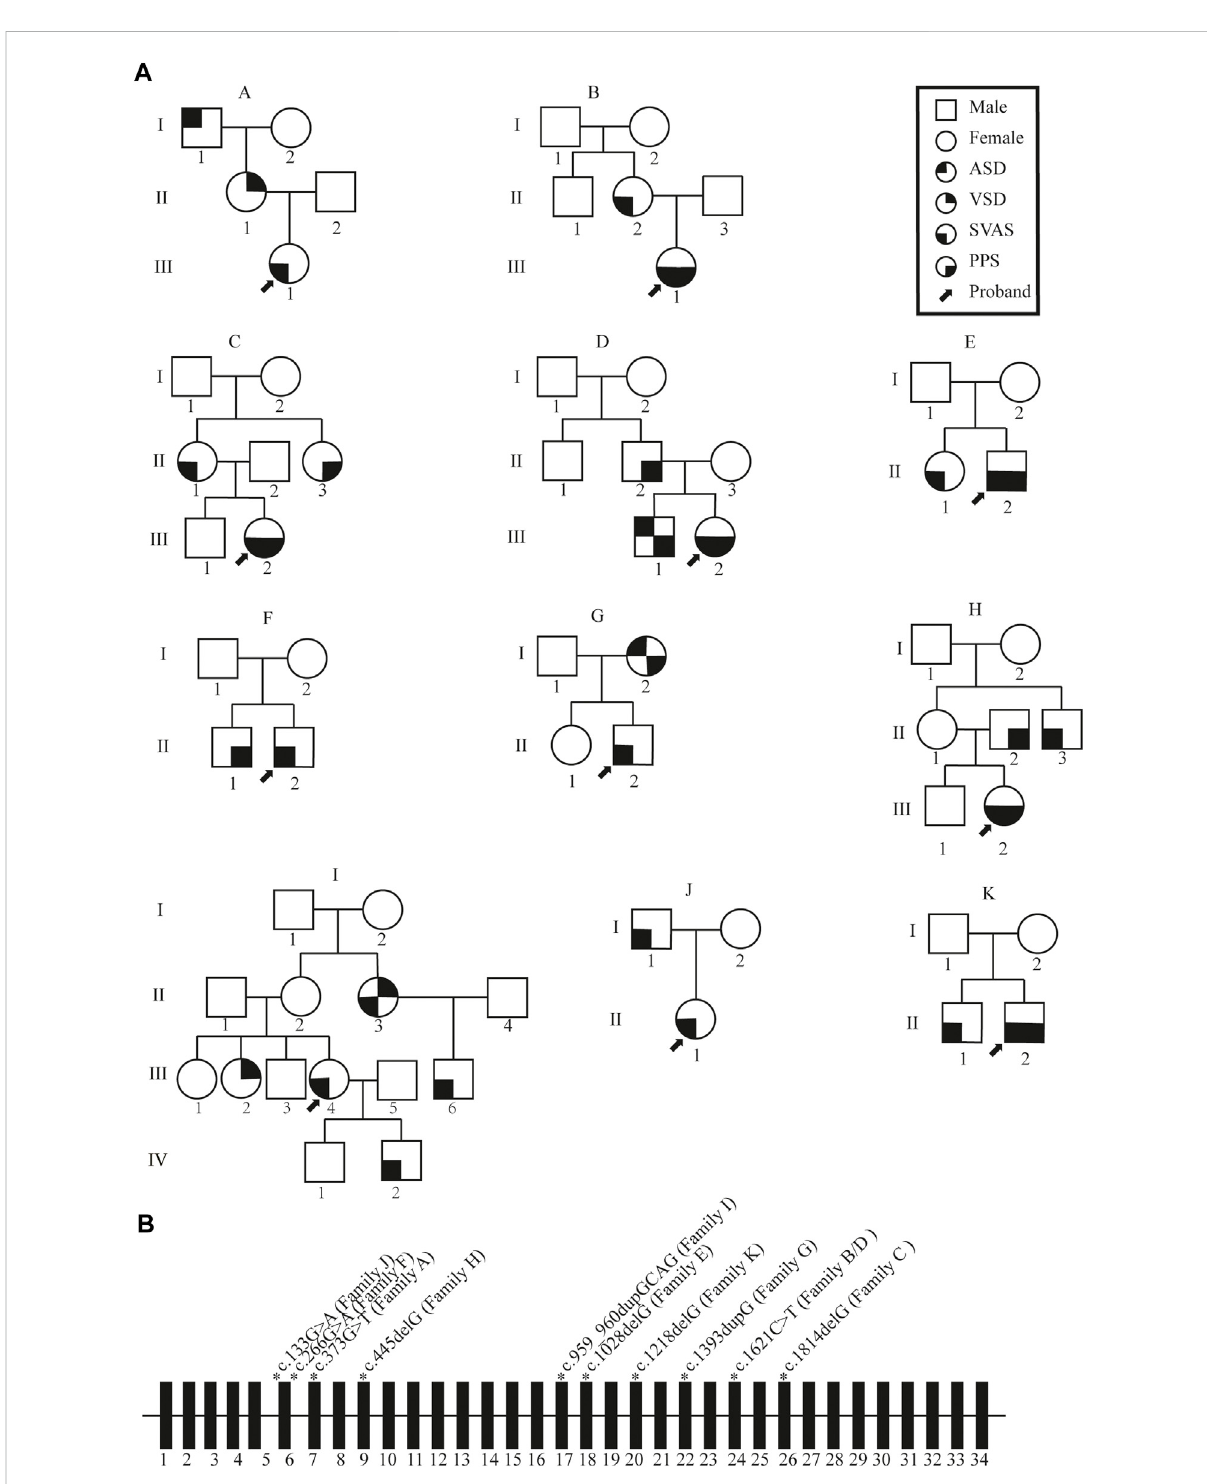
FIGURE 1 Schematic representation of the familial mutation. (A) Pedigree diagram of familial supravalvular aortic stenosis. Arrows indicate probands. I, II, III and Ⅳ correspond to fi rst, second, third and fourth generation, respectively. SVAS, supravalvular aortic stenosis; PPS, peripheral pulmonary stenosis; VSD, ventricular septal defect; ASD, atrial septal defect. (B) Schematic representation of the ELN gene mutations. Rectangles represent exons; thin horizontal line represents introns. The schematic position of the identi fi ed mutations is indicated with a